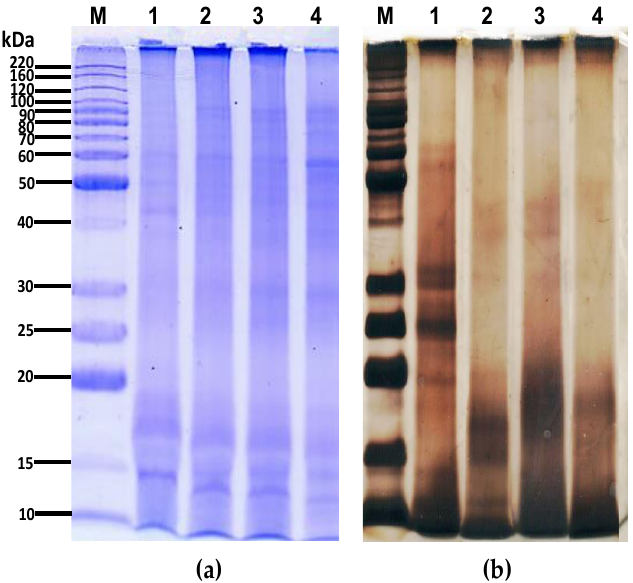
Figure 2. Effect of thermal treatment on the SDS-PAGE pattern of pacaya proteins in ( a ) pacaya flour; ( b ) pacaya protein isolate. Lanes: M: molecular weight marker, 1: extracted from pacaya without thermal treatment, 2: extracted from pacaya under hydrothermal processing, 3: extracted from pacaya via steaming at an elevated temperature, 4: extracted from pacaya under microwave treatment.